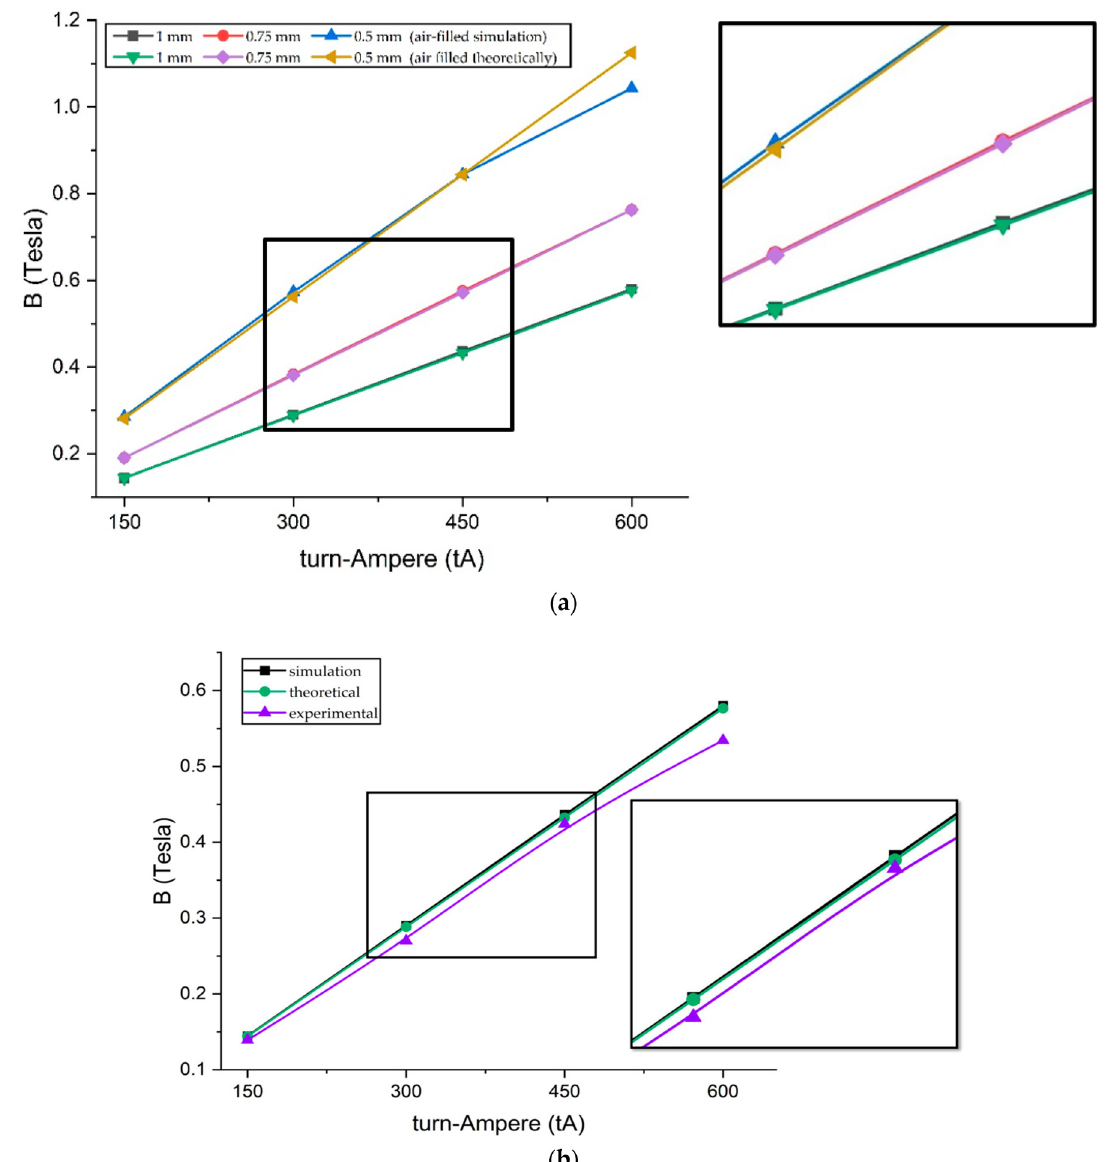
Figure 12. Result of validation tests: ( a ) First scenario vs second scenario; ( b ) First, second, and third scenarios at 1 mm fluid